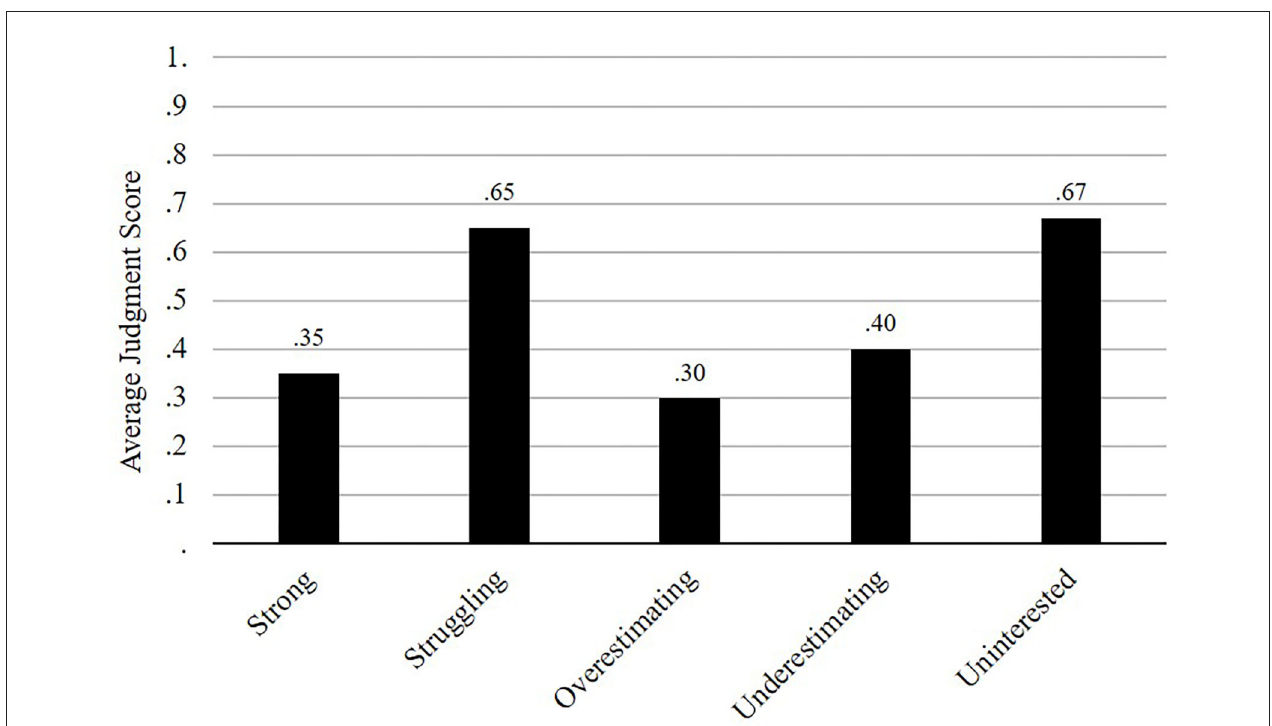
FIGURE 4 | Average judgment accuracy across student profiles.